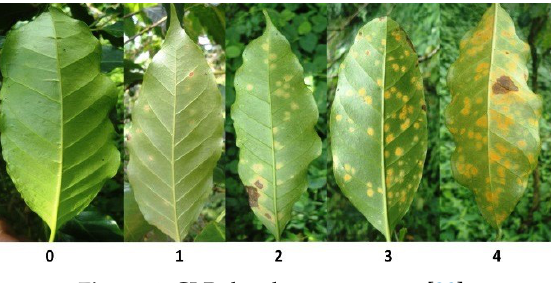
Figure 4. CLR development stages [28].